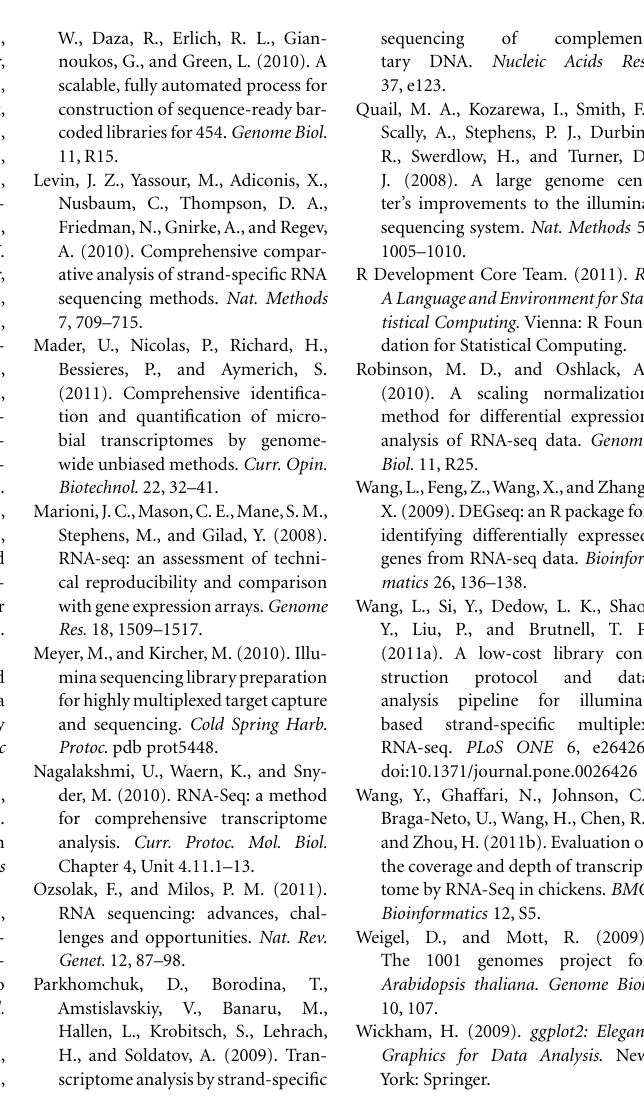
Figure S1 | Overview of Illumina (IL) and high-throughput RNA-seq (HTR) library preparations. Figure S2 | cDNA fragmentation with DNA fragmentase. Figure S3 | Size selection usingAMPureXP beads by PEG concentration. Figure S4 | Coverage analysis in C1 and C2 methods.